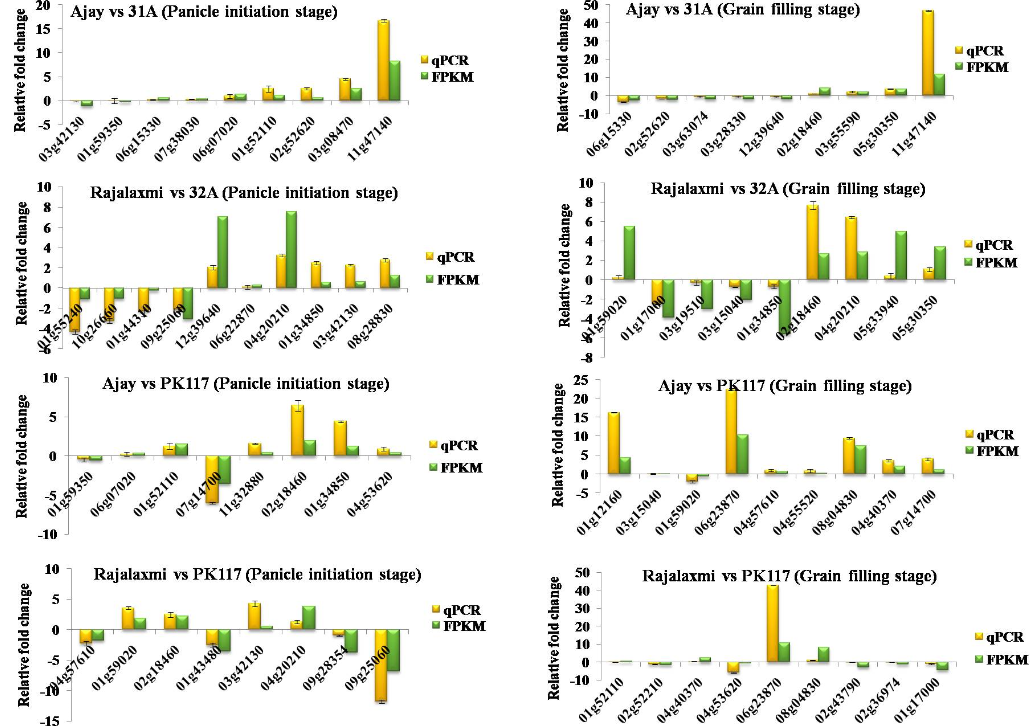
Figure 6. Relative fold change (FC) (qRT-PCR) of selected DEGs identified between rice hybrids (Ajay and Rajalaxmi) and their parental lines at panicle initiation and grain filling stages. FPKM = fragments per kilobase of exon per million fragments mapped.